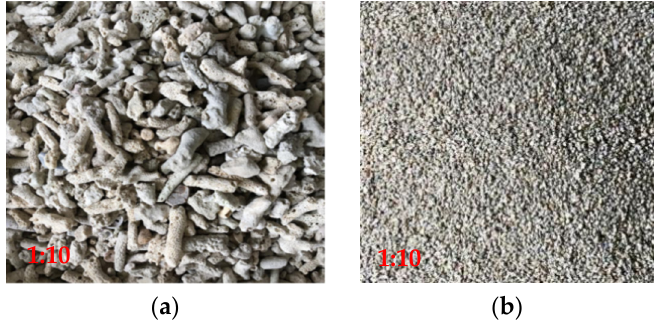
Figure 1. Coral aggregate. ( a ) Coral coarse aggregates. ( b ) Coral fine aggregates. Table 1. Coral aggregate basic physical properties